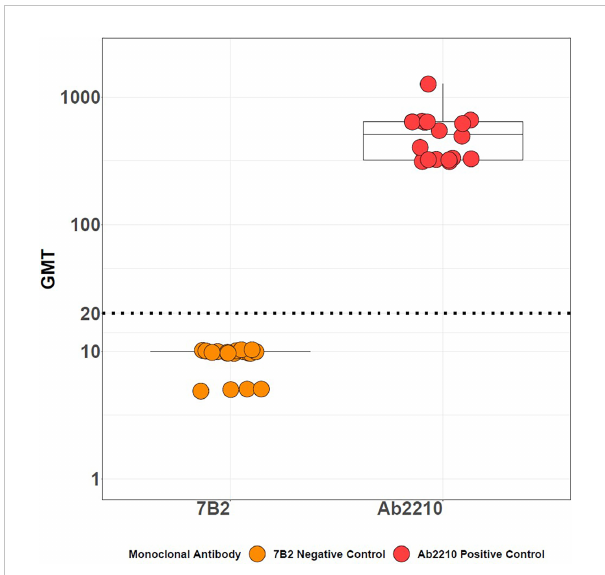
FIGURE 4 HAI assay quali fi cation on H3N2 in fl uenza strain A/Texas/71/2017, matrix effect testing, linearity analysis results. Scatter plot showing correlation analysis output from SAS CORR procedure, between log 10 transformed GMTs for Ab2210 IgG1 diluted in plasma [plotted on y-axis] and Ab2210 IgG1 diluted in serum [plotted on x-axis]. The 70% and 80% prediction ellipses are plotted in red and blue colors, respectively. Sixteen data points are plotted as circles, some circles overlap due to having same values for both x and y axis. The Pearson correlation coef fi cient between serum and plasma log10 GMTs was calculated and determined to be 0.98, with a p-